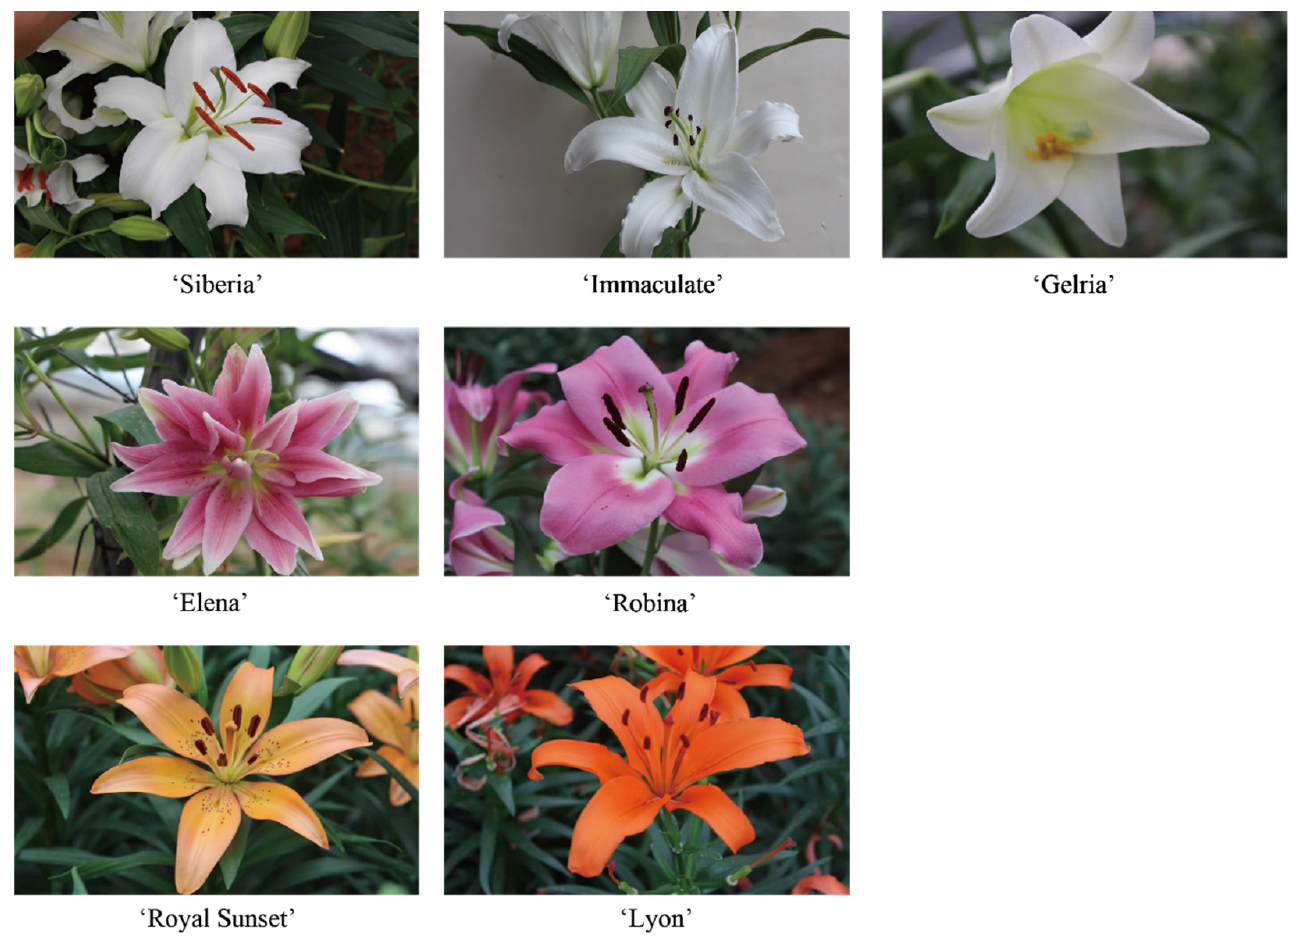
Figure 1. Seven varieties of lily.